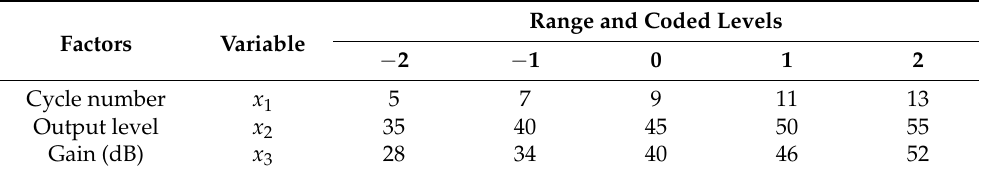
Table 1. Experimental design factors range and